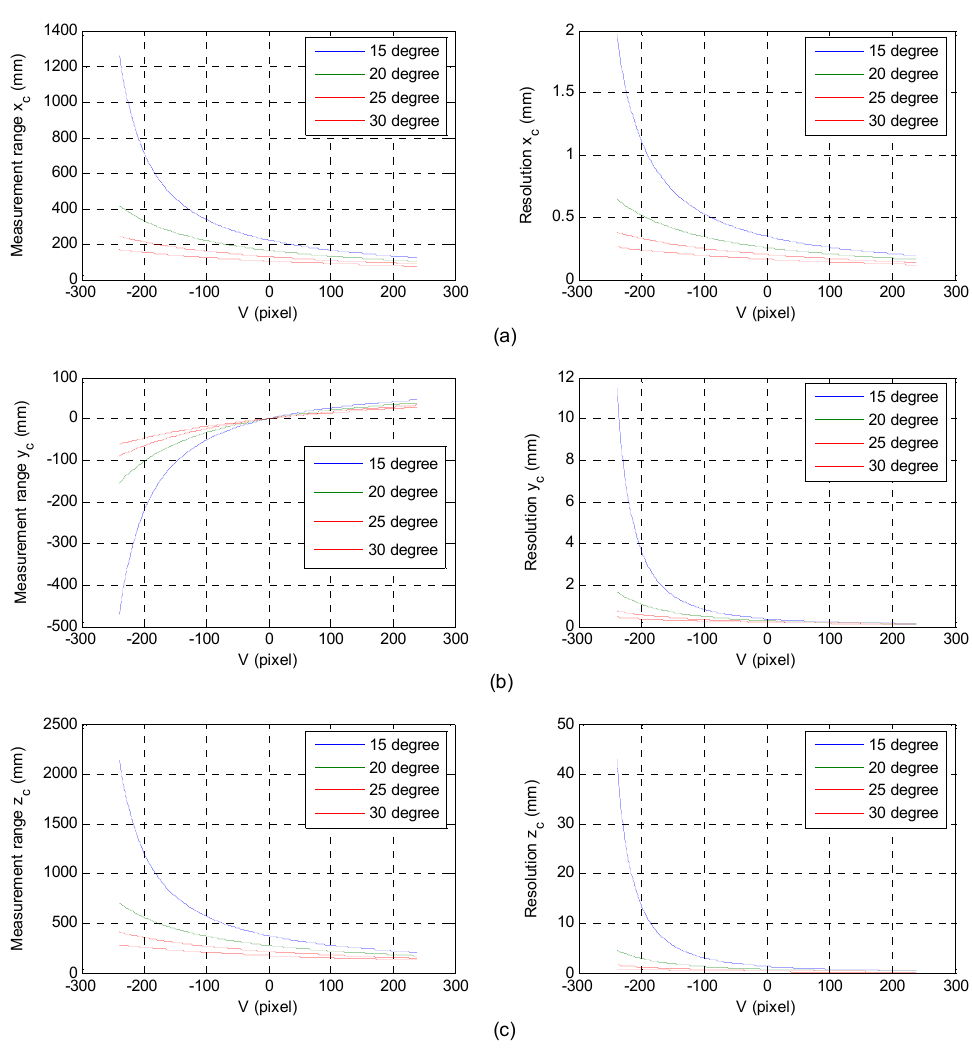
Figure 5 . Measurement range and resolution for different projection angles, where the baseline H is 100 mm.